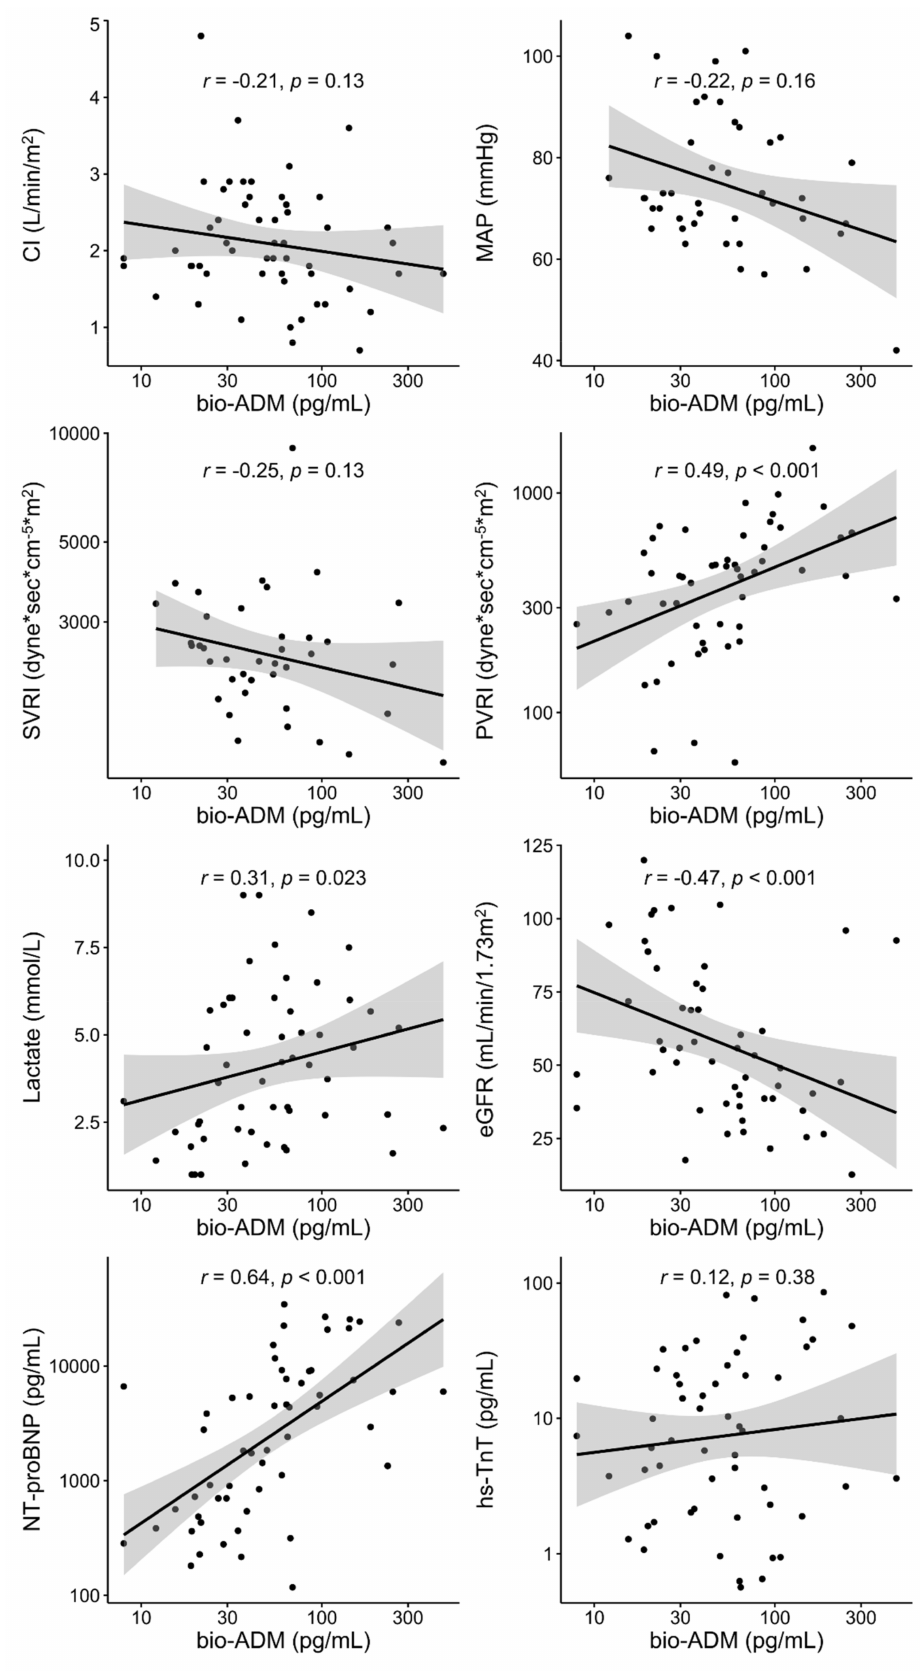
Figure 4. Spearman correlation between bio-ADM and hemodynamic and biological